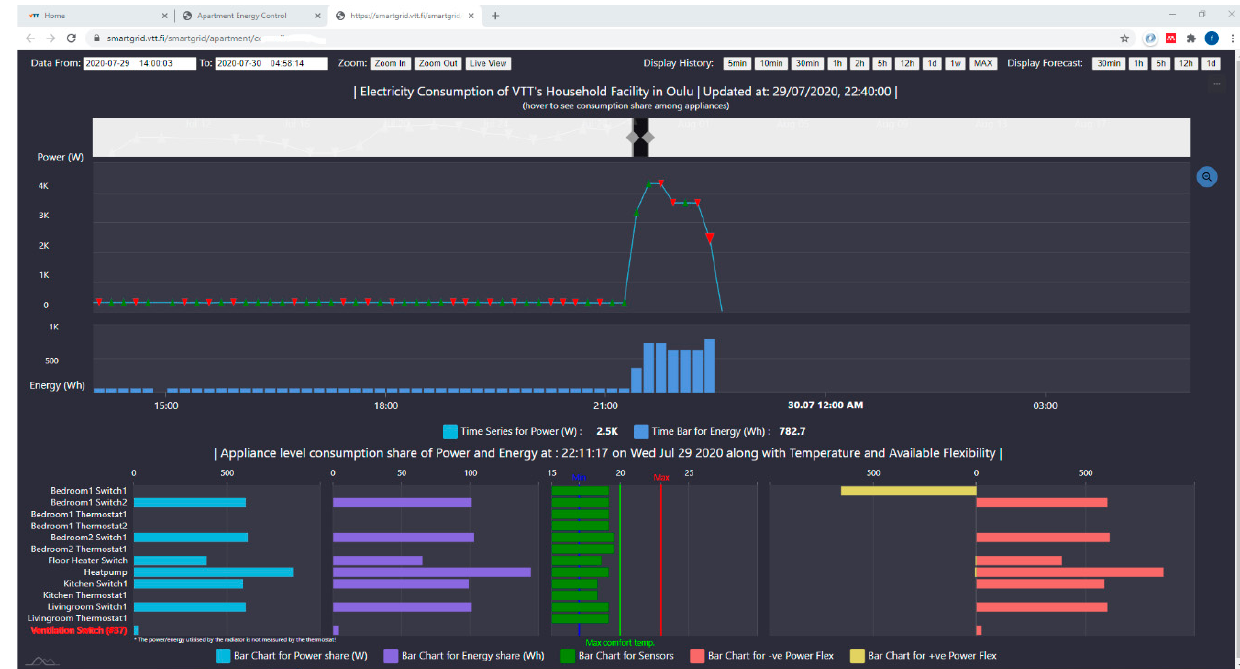
Figure 7. Monitoring the user interface.